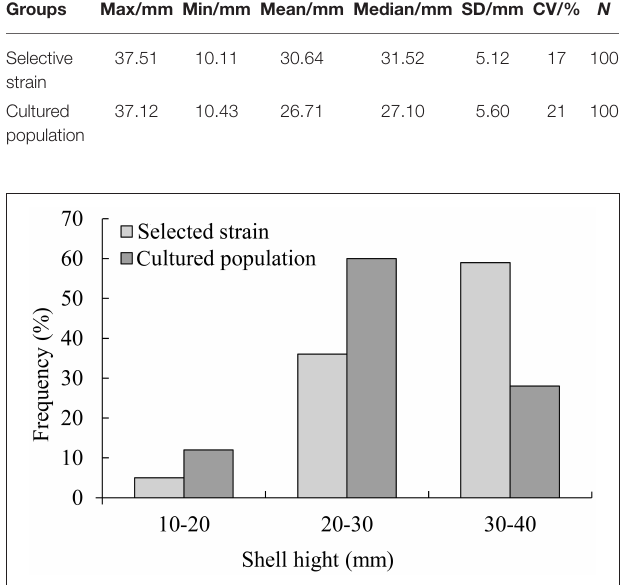
TABLE 2 | Statistical description of shell height of two groups of 6-month old pearl oysters. Groups